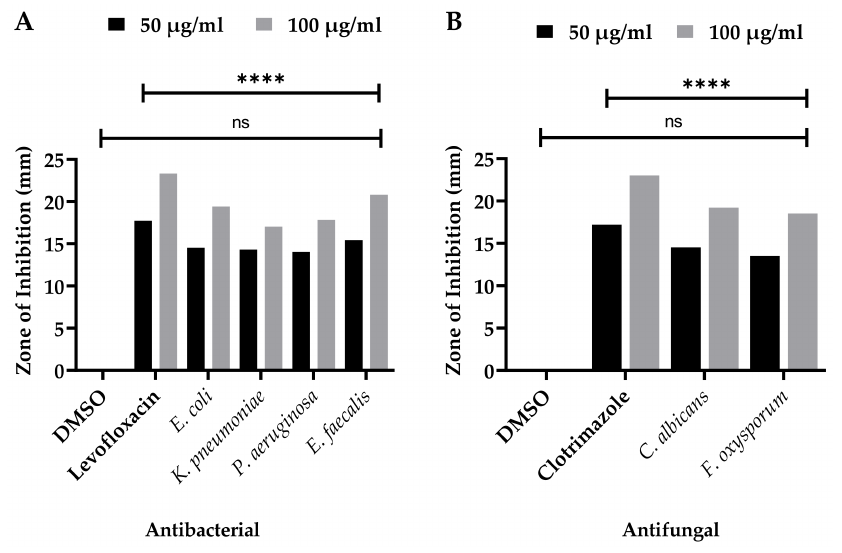
Figure 3. Zone of inhibition’s ( A ) antibacterial and ( B ) antifungal potential zone of inhibitions of essential oils of S. edelbergii ; DMSO = negative control; levofloxacin and clotrimazole = positive control. Data were taken in triplicate ( n = 3) and analyzed through two-way ANOVA, via Sidak’s multiple comparison test, ns = >0.9999, p = **** <